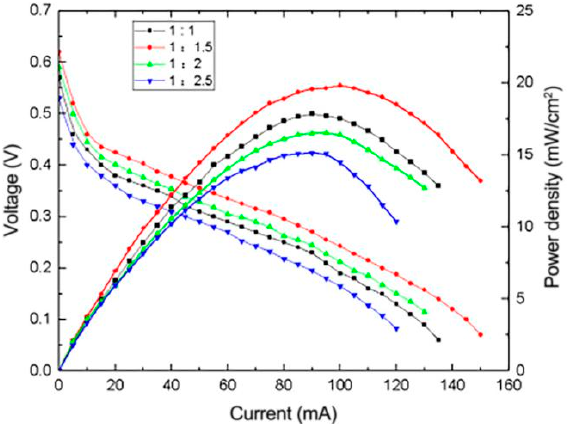
Figure 9. Effect of Pt-Ru molar ratio on the performance of µ DMFC.